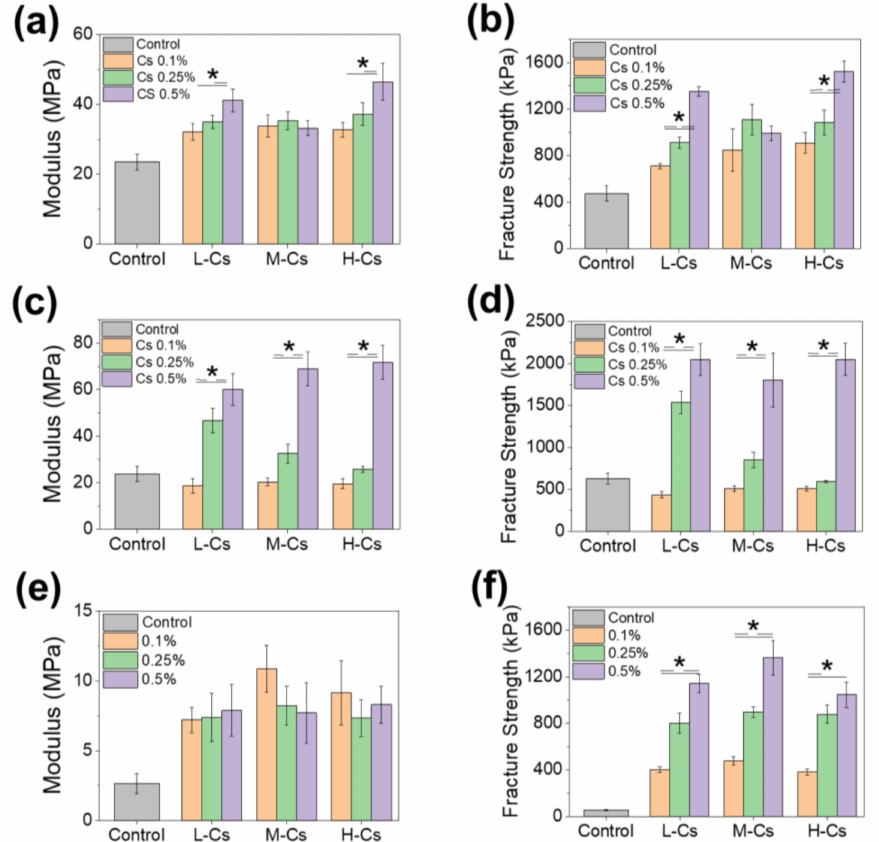
Figure 8. Tensile moduli and fracture strength of ( a , b ) Low S% seaweed paper, ( c , d ) High S% seaweed paper and ( e , f ) plant paper coated with chitosan with varying concentrations and molecular weights M W (* p < 0.05). Uncoated papers were used as